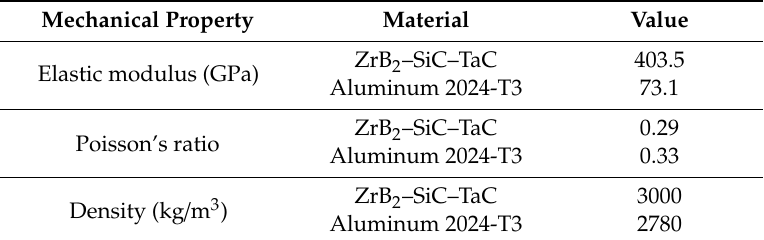
Table 1. Rigidity and elastic modulus of each phase.